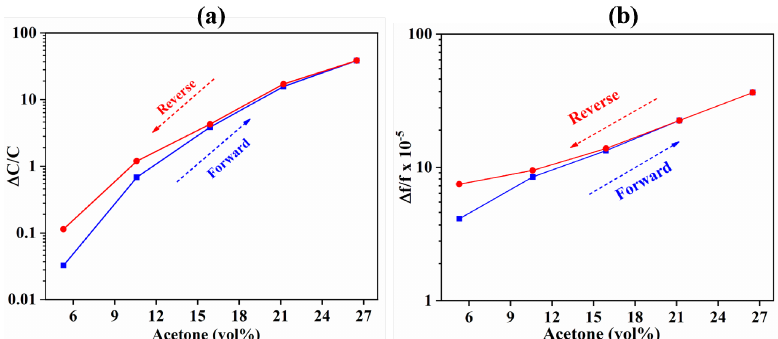
Figure 6. Hysteresis of ( a ) capacitive-based and ( b ) QCM-based sensors. The desorption cycle lagged behind the adsorption cycle by a maximum of approximately 3 vol % at 5.3 vol % of acetone.